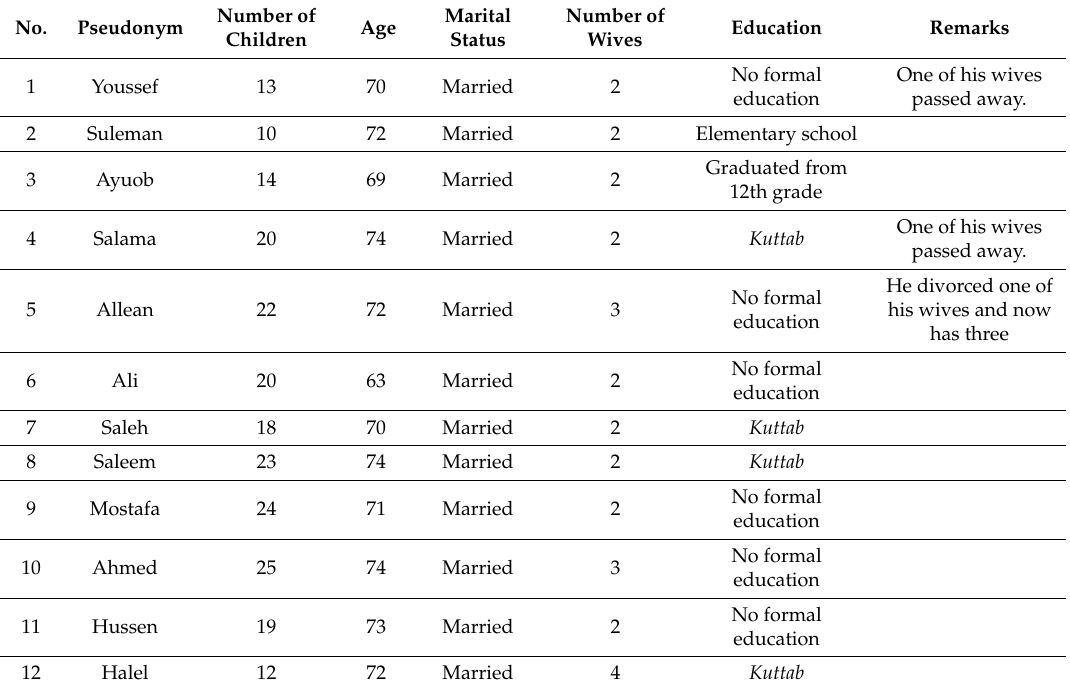
Table 1. Demographic Description of the